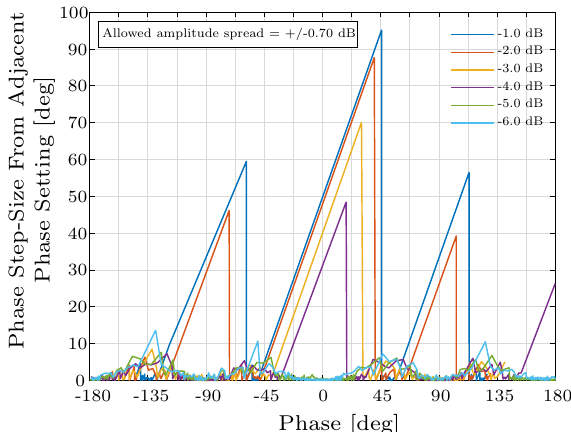
Fig. 4 Phase step size between adjacent phase settings at 58.32 GHz, for a number of fixed amplitudes. 0 dB is set to the highest possible